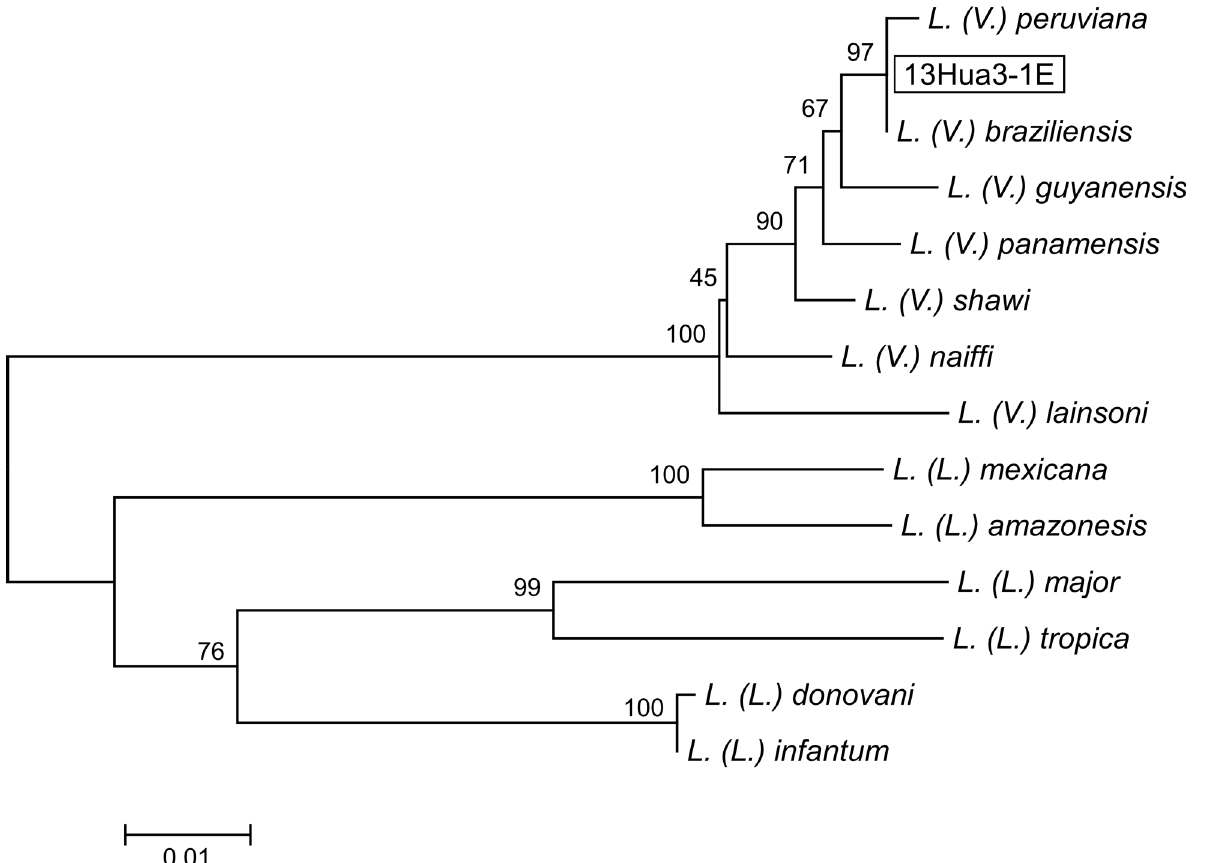
Fig 1. Phylogenetic tree of cytochrome b ( cyt b) gene sequences among species. Leishmanial cyt b genes were amplified and sequenced from a sand fly, Lutzomyia tejadai (13Hua3-1E). A phylogenetic analysis of cyt b gene sequences was performed by the neighbor-joining method together with sequences from 13 Leishmania species. The scale bar represents 0.01% divergence. Bootstrap values are shown above branches.